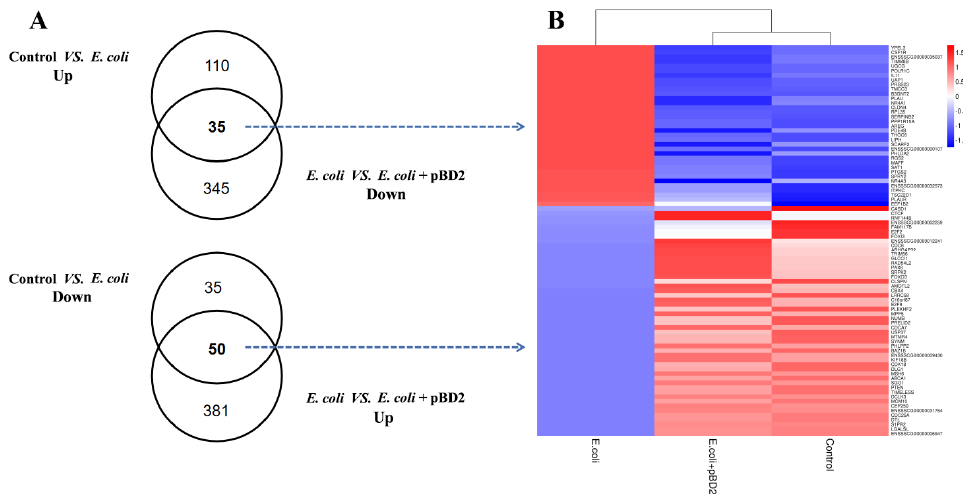
Figure 8. Overview of the DEGs after different treatments. ( A ) Venn diagrams of known DEGs based on comparisons of different groups. ( B ) Hierarchical clustering of the overlapping DEGs among different groups. The red indicates upregulated genes and the blue indicates downregulated genes.